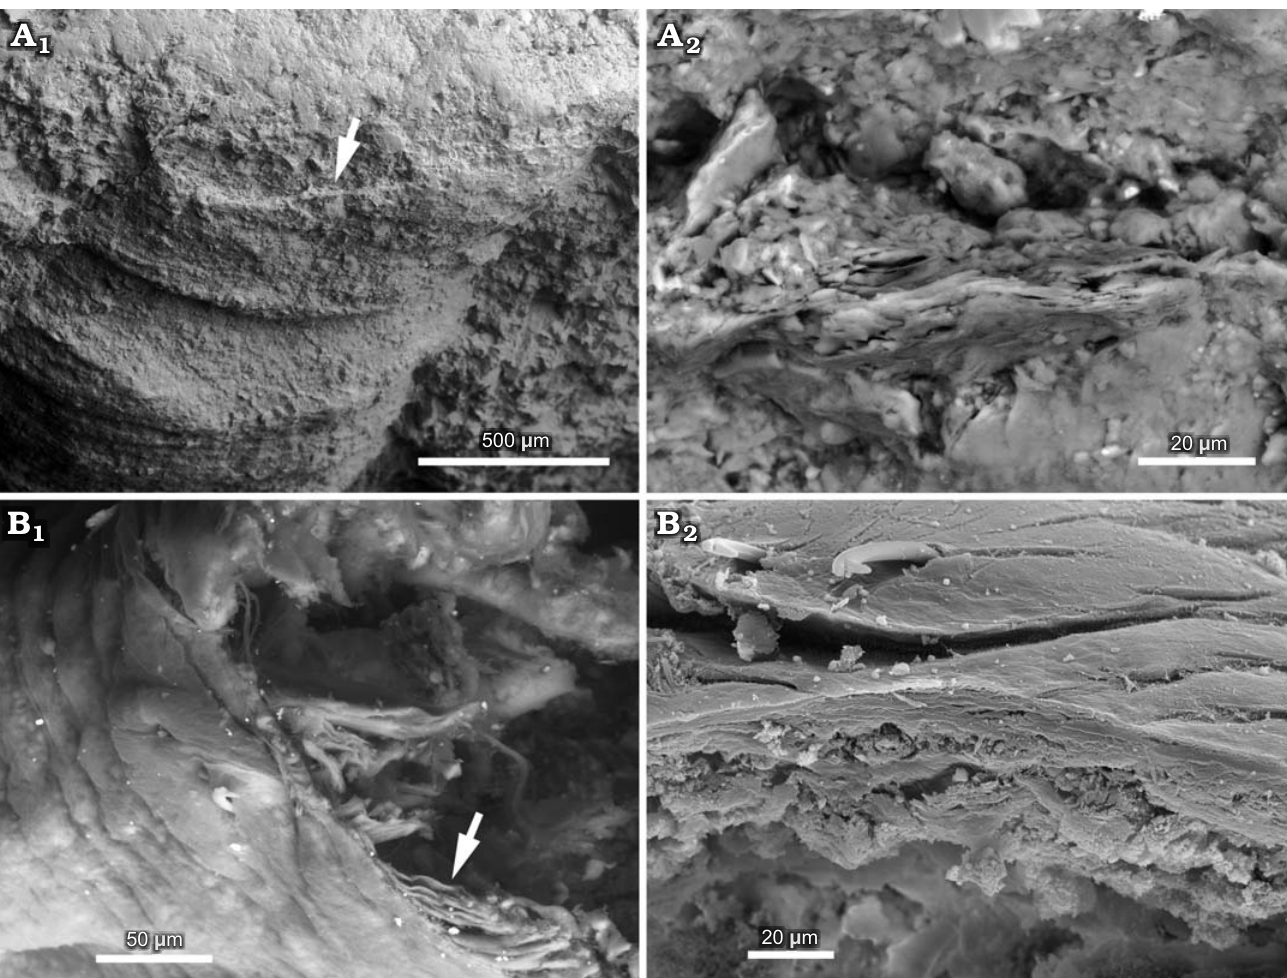
Fig. 4. Microdrile oligochaete PIN 5640/212 ( A ) from the Petropavlovka Formation, Olenekian (Lower Triassic), Petropavlovka III section, Russia and extant Tubifex tubifex (Müller, 1774) ( B ) from the Khripan’ River, Moscow region, Russia. A . Oblique view of posterior end emphasizing body wall laye- ring (arrowed), prominent raised annuli and finer annulets (A 1 ). Detail of body wall layers ( А 2 ). B . Body wall layers (arrowed; B 1 , B 2